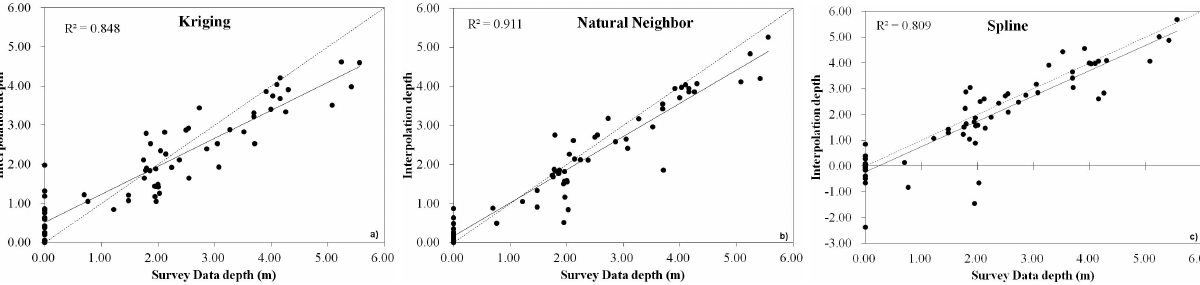
Fig. 7. Correlation of inundation depth from survey data points and interpolation methods. The Natural Neighbor method shows the best correlation with the real data.